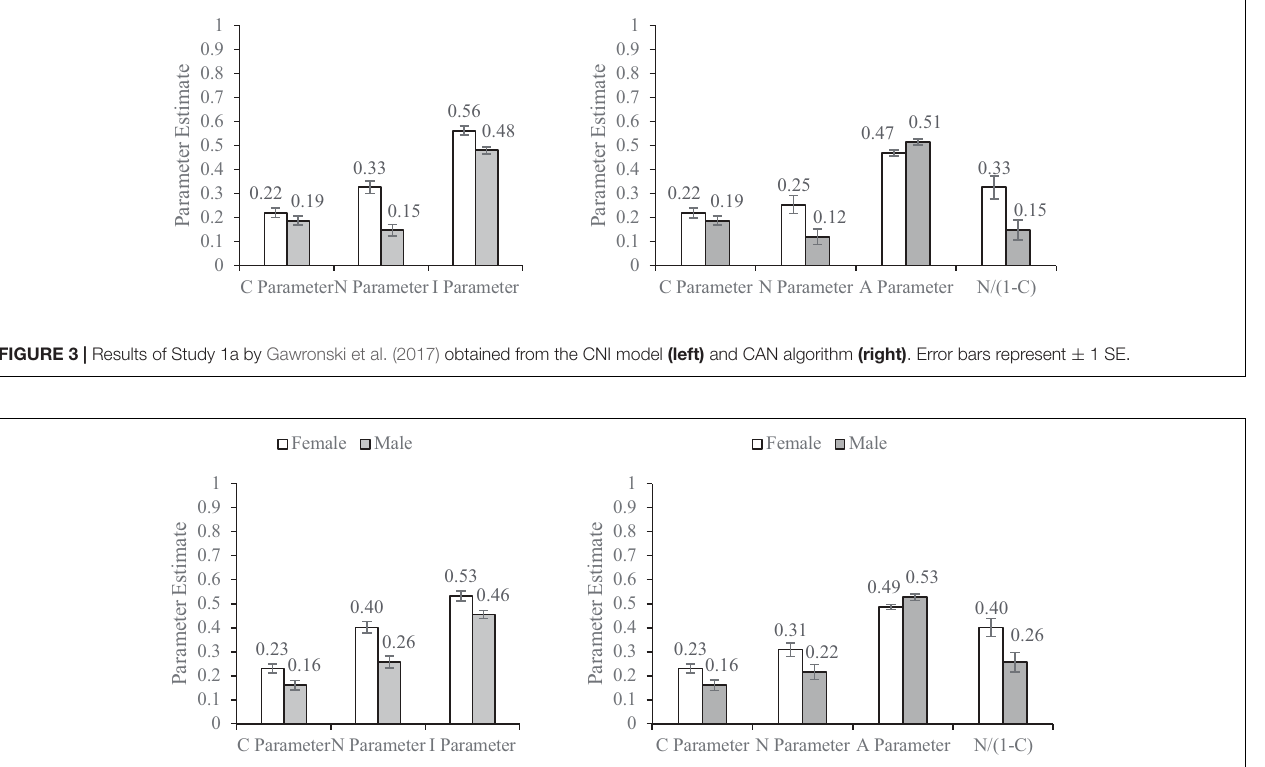
FIGURE 4 | Results of Study 1b by Gawronski et al. (2017) obtained from the CNI model (left) and CAN algorithm (right) . Error bars represent ± 1 SE.